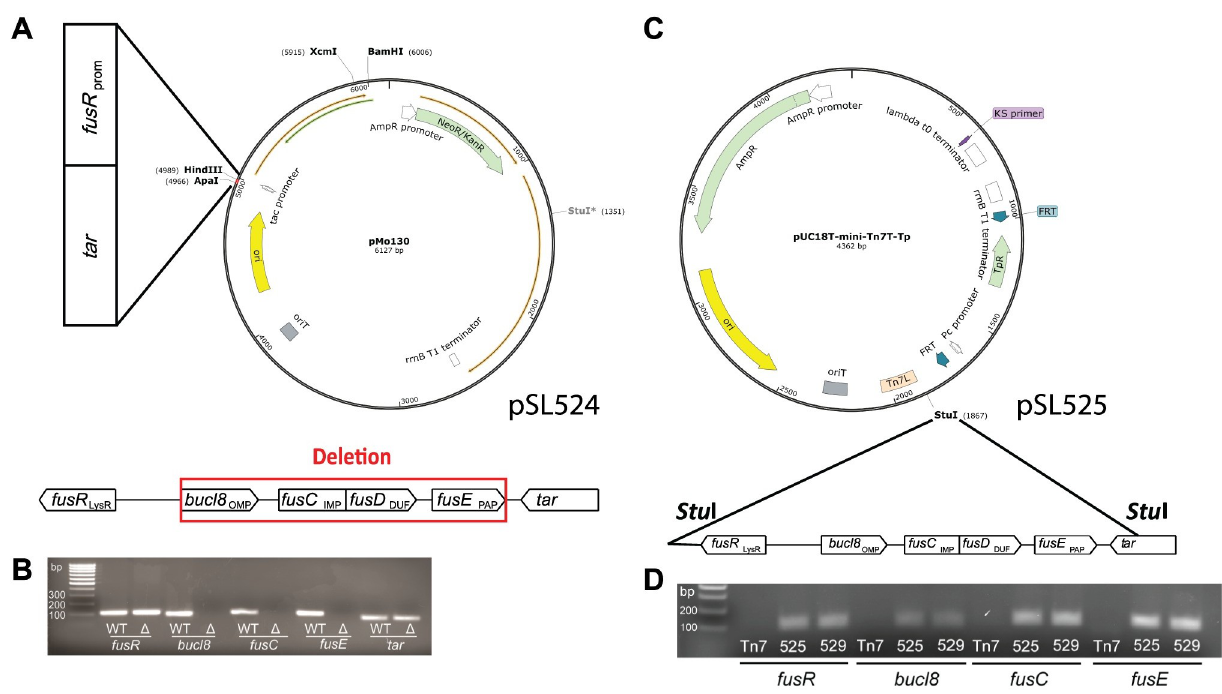
Fig 5. Construction of an unmarked Bucl8-associated pump deletion mutant and complementation in a heterologous host. (A) Strategy for generating an unmarked Bucl8-pump deletion mutant. Construction of the suicide plasmid construct pSL524. Vector pMo130, which is suicide in Burkholderia , was used to generate pSL524 plasmid construct for mutagenesis. Hind III and Apa I sites were utilized to clone flanking regions containing fusR and tar sequences to delete the bucl8-fusE coding region, depicted below. (B) Analysis of the bucl8-fusE deletion mutant of Bp82 by PCR. The presence of bucl8-fusE genes was tested in the genomic DNA isolated from wild type Bp82 (WT) and Bp82 bucl8-fusE mutant ( Δ ). (C) Cloning of the Bucl8-pump locus for in-trans complementation in E . coli . Vector pUCT18T-mini-Tn7T-Tp was used for cloning of an 8.2-kb genomic Bp82 fragment, flanked by Stu I sites, encompassing bucl8 locus. (D) Characterization of the pSL525 and pSL529 constructs. The presence of fusR-fusE genes on pSL525 and pSL529 plasmids was tested by PCR. PCR products shown in B and D were analyzed on 1.3% agarose gel.